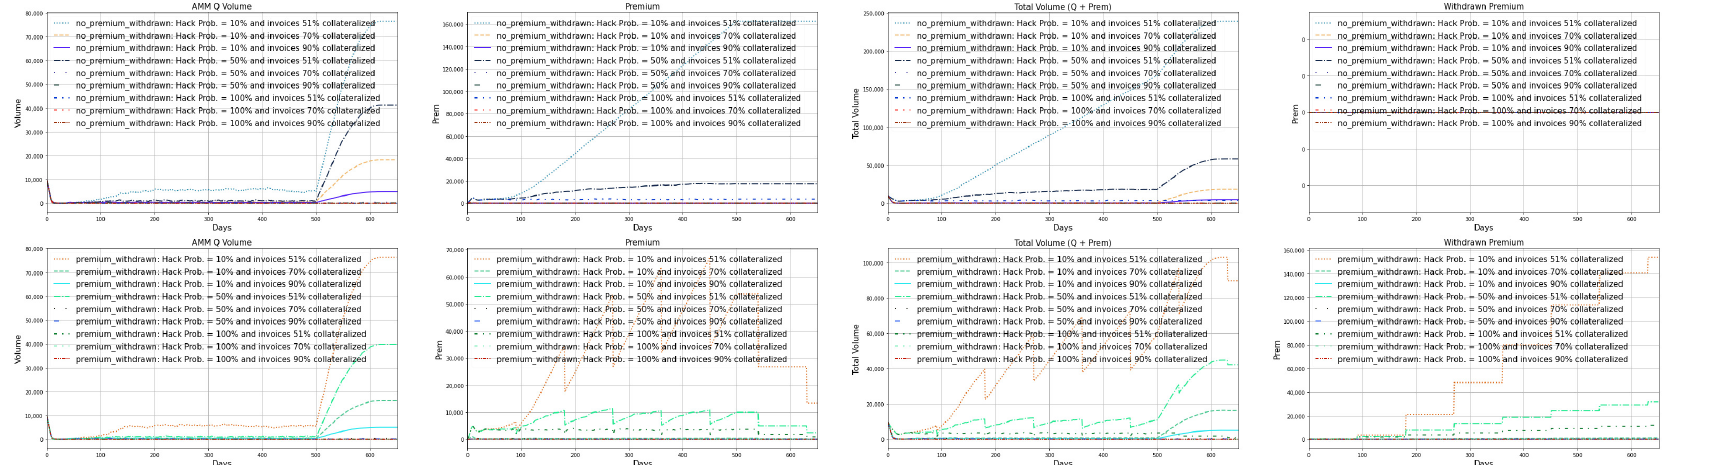
Figure A16. rkAMM Curves from simulation of hack scenario and 90 days of withdrawal